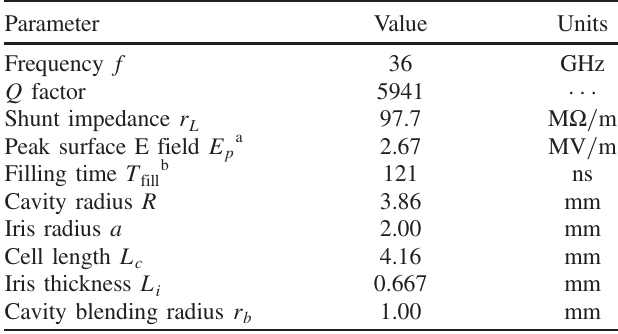
TABLE VI. SWS single cell parameters.